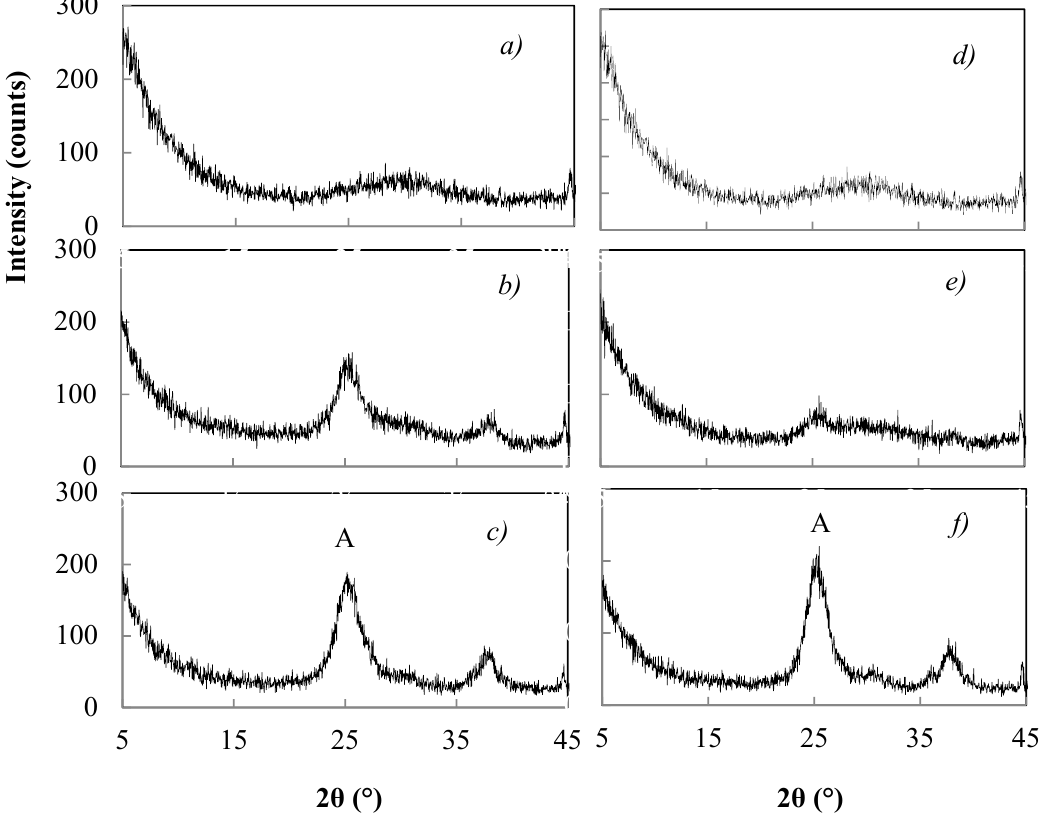
Figure 2. XRD patterns of products hydrolyzed for 1 h in the presence of NH 4 OH 0.07 M ( a – c ) or 1.0 M